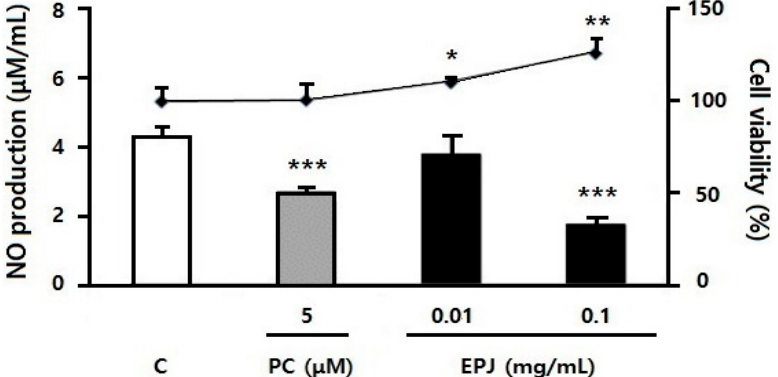
Figure 1. Extracted Petasites Japonicus (EPJ) inhibited lipopolysaccharides (LPS)-induced nitric oxide production in RAW 264.7 macrophages. All groups were incubated with LPS (100 nM) and positive control (PC, troglitazone 5 µ M) or 0.01 or 0.1 mg / mL EPJ. The three treatment groups (PC and both of EPJ groups) were compared with the control (C; LPS treated only) group. Data are mean ± S.D. of four independent determinations. * p < 0.05, ** p < 0.01, *** p < 0.001.